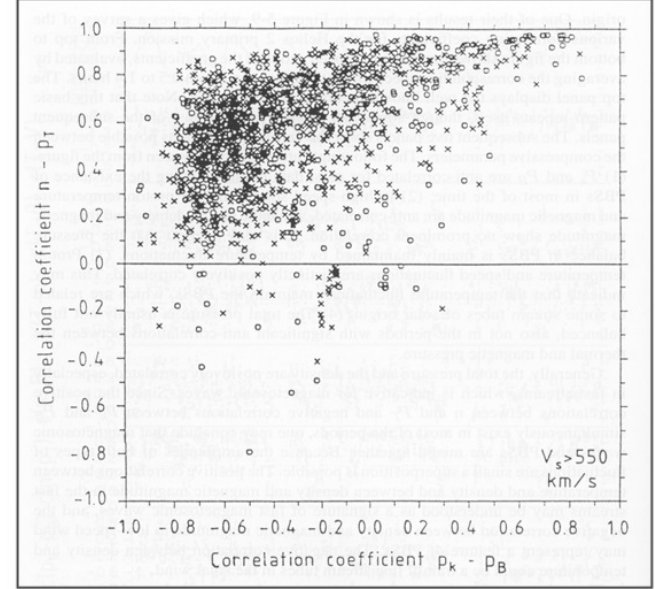
Figure 74: Correlation coefficient between number density 𝑛 and total pressure 𝑝 T plotted vs. the cor- relation coefficient between kinetic pressure and magnetic pressure for both Helios relatively to fast wind. Image reproduced by permission from Marsch and Tu